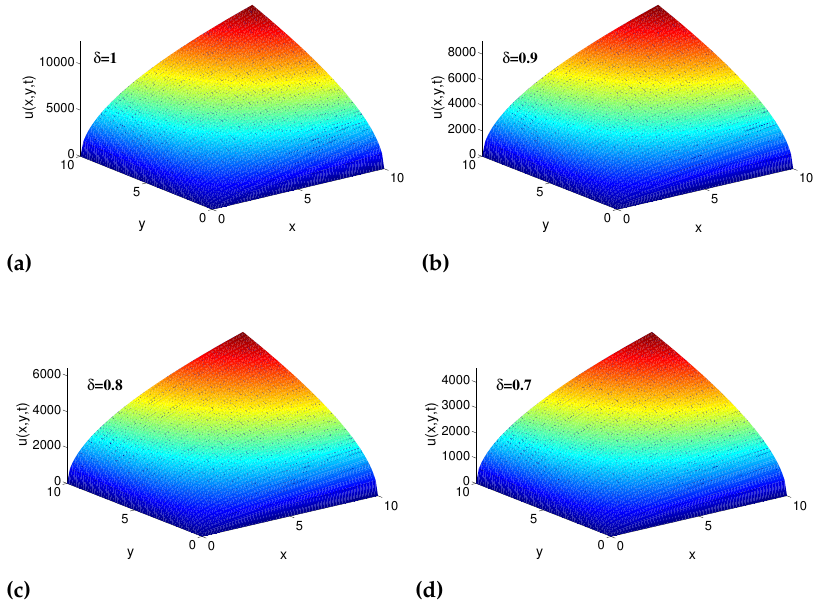
Figure 1. The numerical simulations of Equation (10) with ( a ) δ = 1 , k = 3 ( b ) δ = 0.9, k = 3 ( c ) δ = 0.8, k = 3 ( d ) δ = 0.7, k = 3 and t = 10.